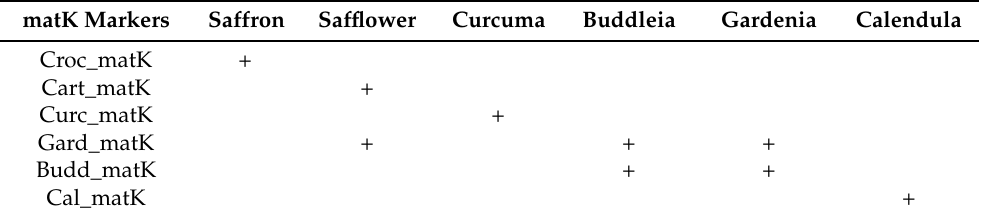
Table 5. Specificity of the amplification carried out with the selective primers developed in the project. matK